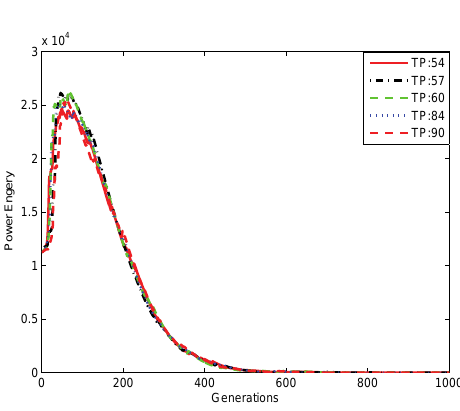
Figure 10: Di ff erent swarm topologies lead to di ff erent power energy in the evolutionary process